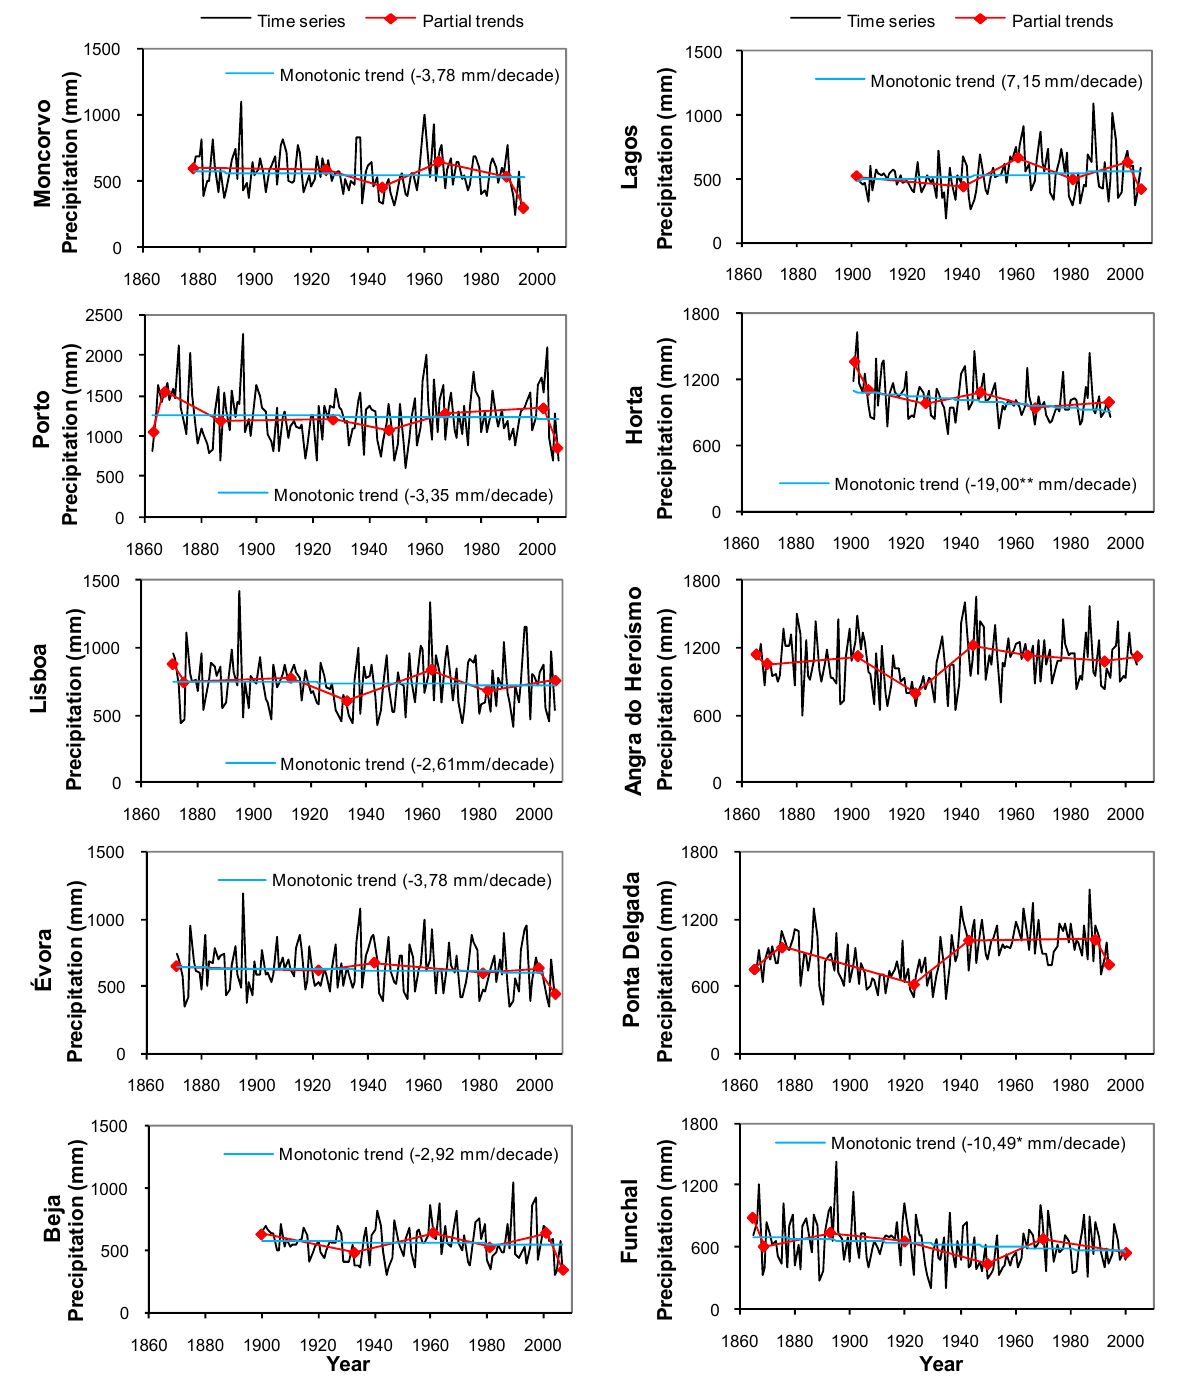
Fig. 2. Annual precipitation series for six stations in mainland Portugal and four stations in the islands. Sen’s estimator of the slope of monotonic trends over the full record periods (blue line) is indicated in the legend. The red line is the fit for partial trends. For better visualization, note that the Y axes scales are not the same for all the plots.